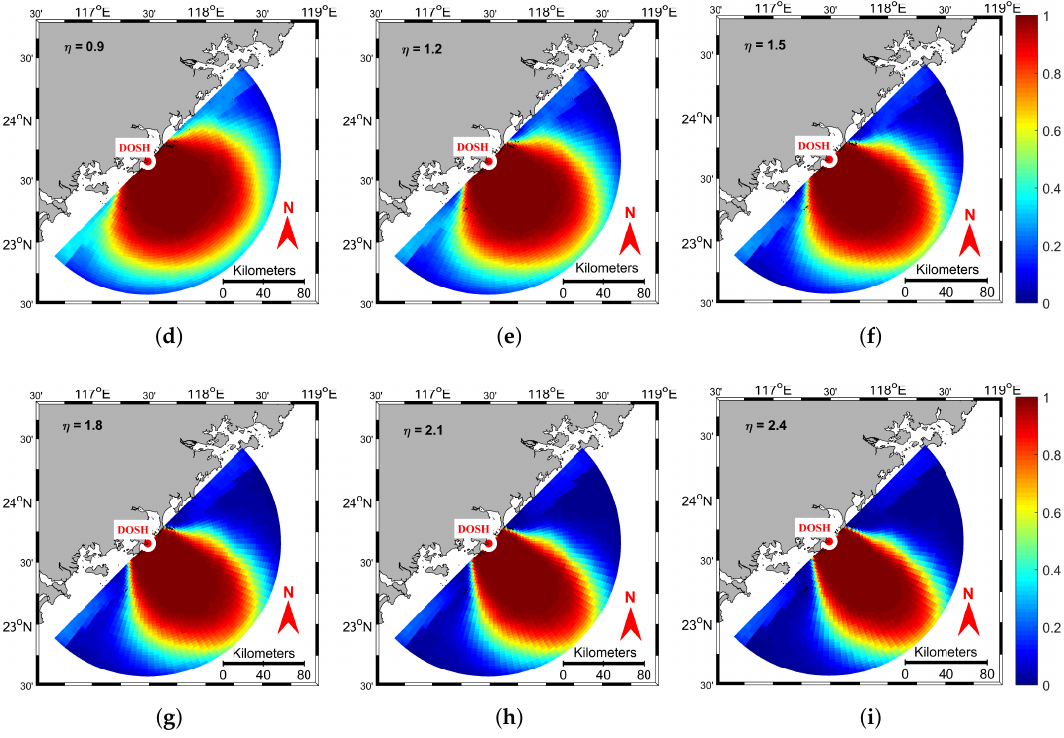
Figure 5. Spatial distribution of the temporal rate for radial current extracted in the case of different correction factor: ( a ) η = 0.1, ( b ) η = 0.3, ( c ) η = 0.6, ( d ) η = 0.9, ( e ) η = 1.2, ( f ) η = 1.5, ( g ) η = 1.8, ( h ) η = 2.1, and ( i ) η = 2.4.